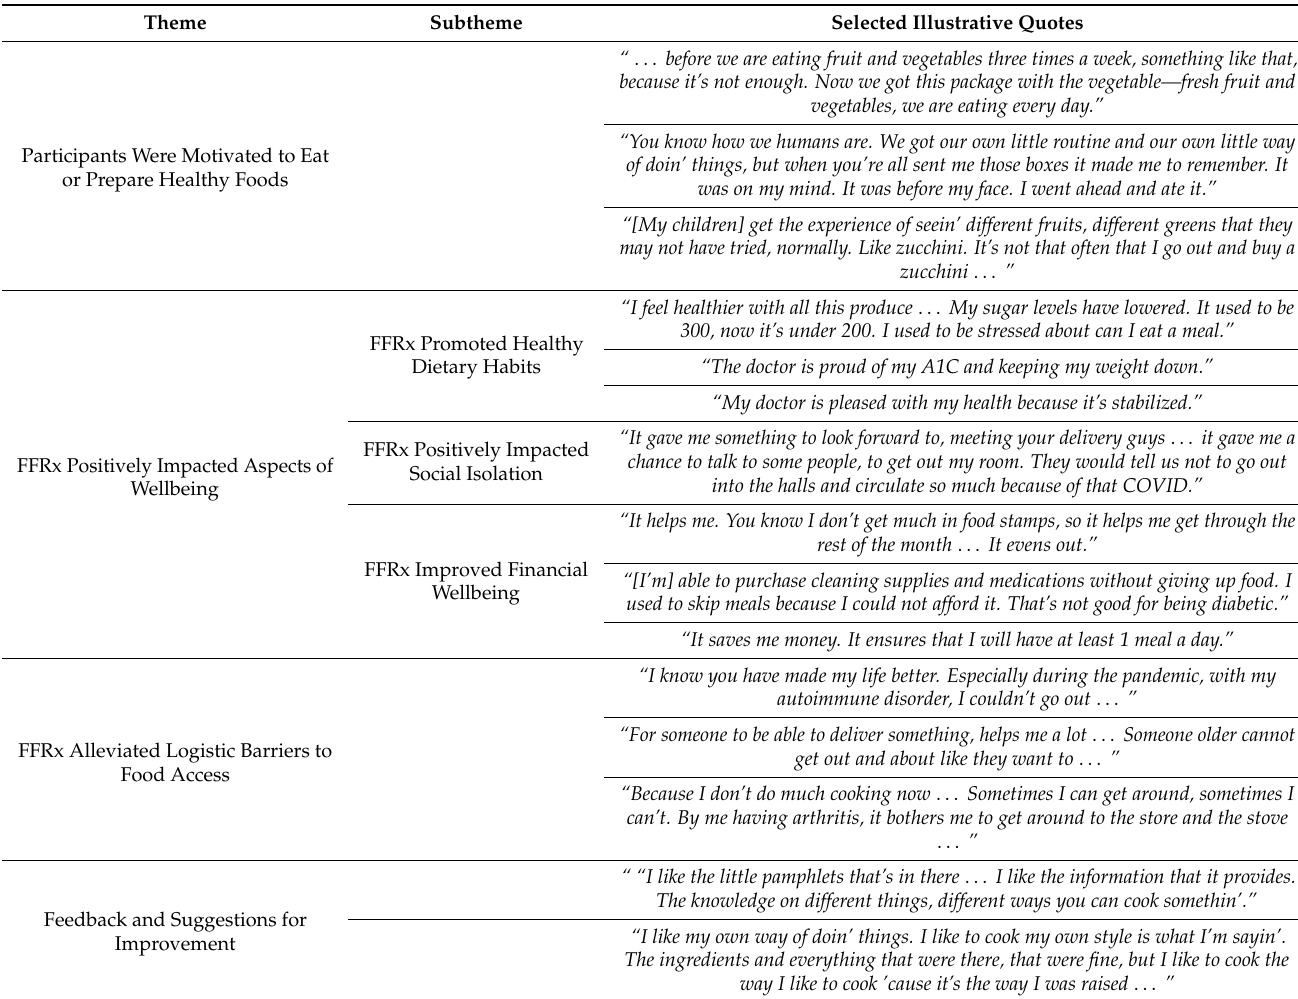
Table 5. Key Themes and Illustrative Quotes of FFRx Interview